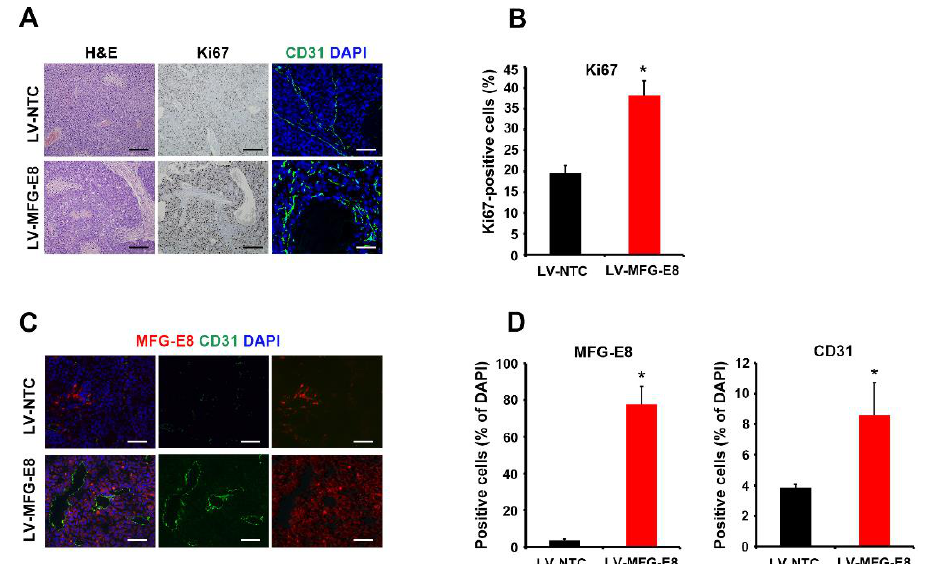
Figure 8. Histological analysis of HCC xenografts. ( A ) Tissue sections were stained with hematoxylin and eosin (H&E), anti-Ki67 antibody, and anti-CD31 antibody. Scale bars, 50 μm. ( B ) Quantitation of Ki67-positive cells. ( C ) Immunofluorescence staining of HCC xenografts for MFG-E8 (red) and CD31 (green). Cells were counterstained with DAPI (blue). Quantitation of immunoreactive cells is shown in ( D ). Scale bars, 50 μm. * p < 0.05, two-tailed Student’s t -test.